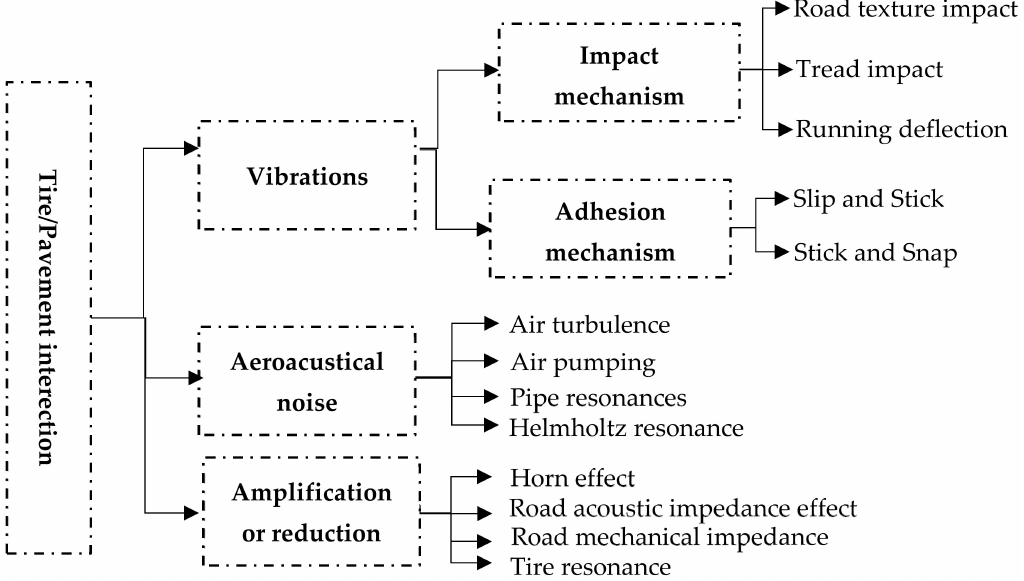
Figure 6. Road noise mechanisms due to tire-pavement interaction (adapted from [14]).